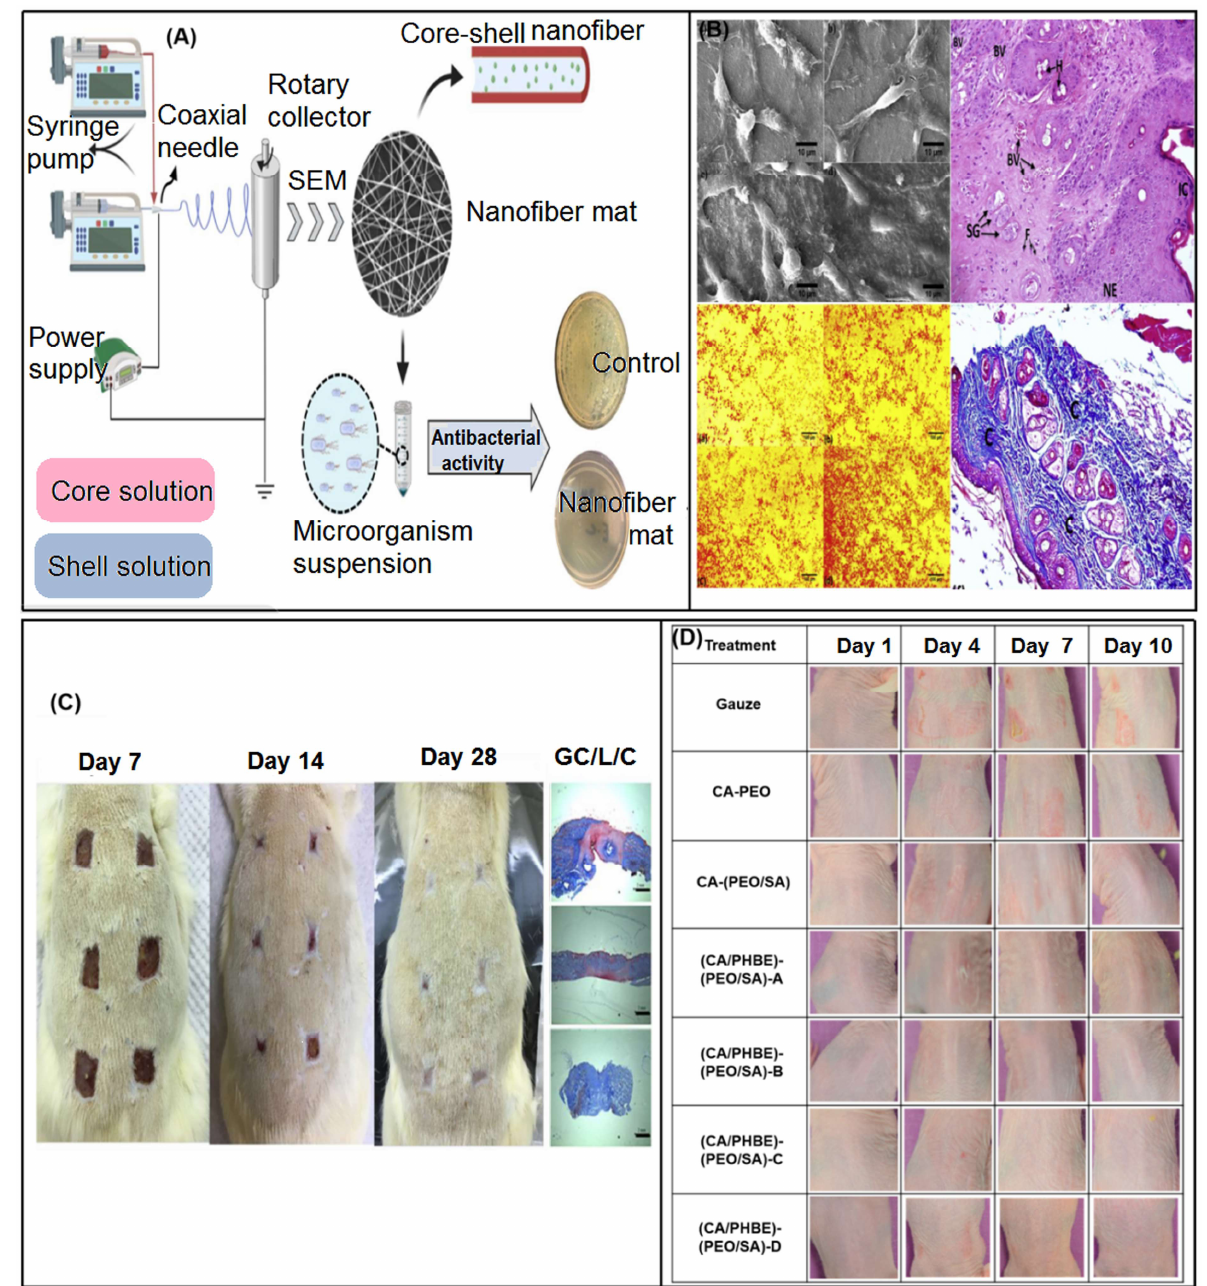
Figure 12. Application of herbal medicine incorporated nanofibers in different wound types. ( A ) CS/PVA/EO-PVP/MD core-shell nanofiber scaffold for wound dressing strategy, reprinted with permission from [10] copyright 2021, Elsevier. ( B ) Effects of the bioactive substance Lawononia inermis fiber for burn strategy on cells and collagen and in vivo evaluation (H: hair follicles; bV: blood vessels; f: fibroblasts; c: Collagen; iC: inflammatory cells; sG: sebaceous gland; nE: new epithelialization), reprinted with permission from [223] copyright 2018, Elsevier. ( C ) Treatment of skin regeneration in mice with double herbal medicines for diabetic wounds, reprinted with permission from [231] copyright 2019, Polymers. ( D ) Clinical evaluation of skin inflammation, reprinted with permission from [44] copyright 2019, Materials.